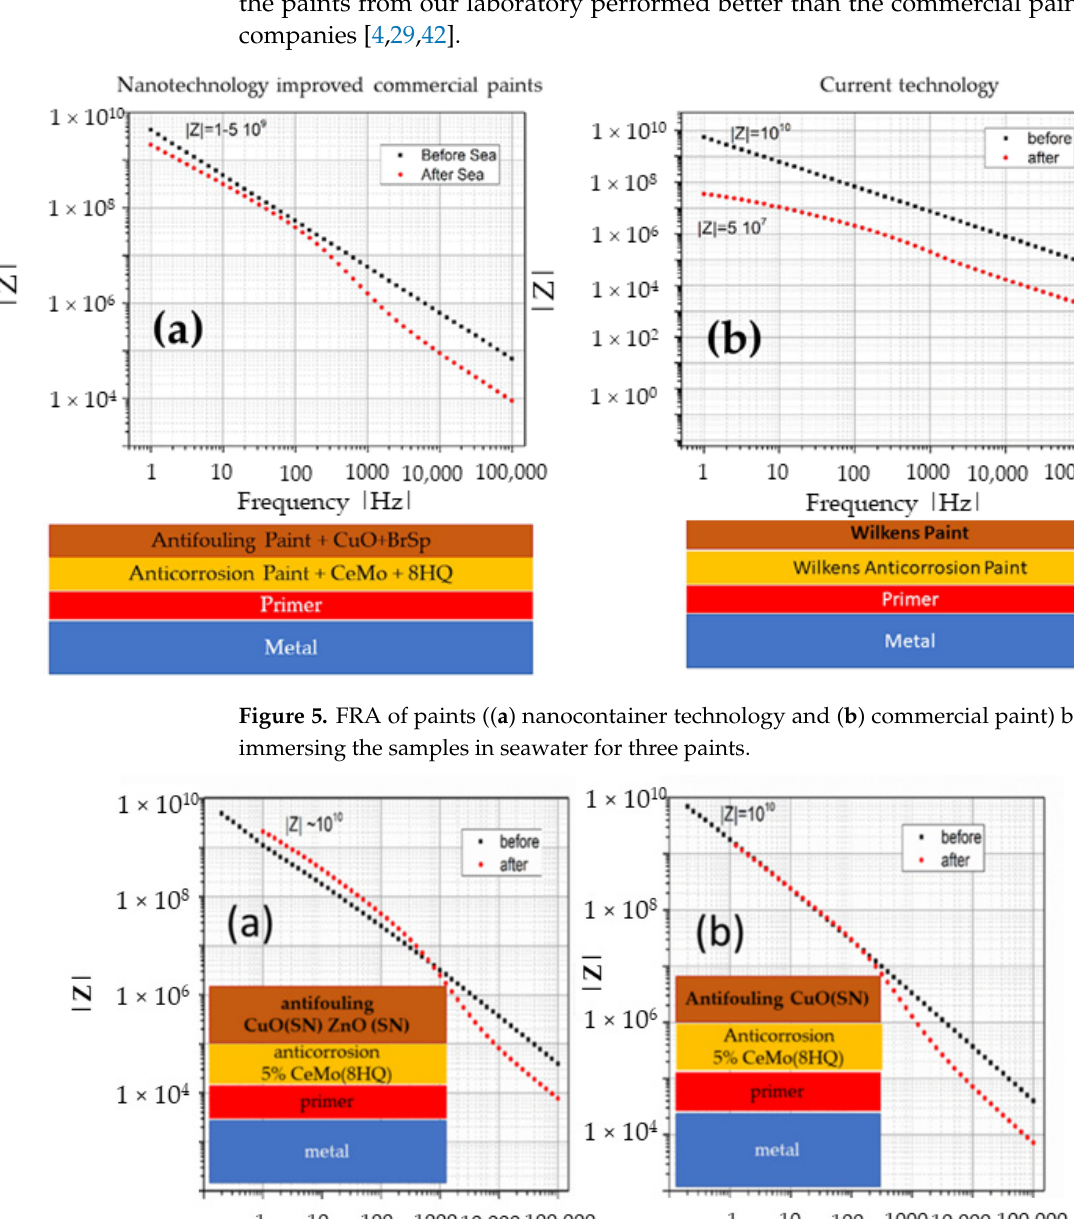
Figure 6. FRA of the paints: ( a ) top layer consisting of CuO (S.N.) and the ZnO (S.N.) nanocontainers, and ( b ) top layer consisting of CuO (S.N.) nanocontainers.